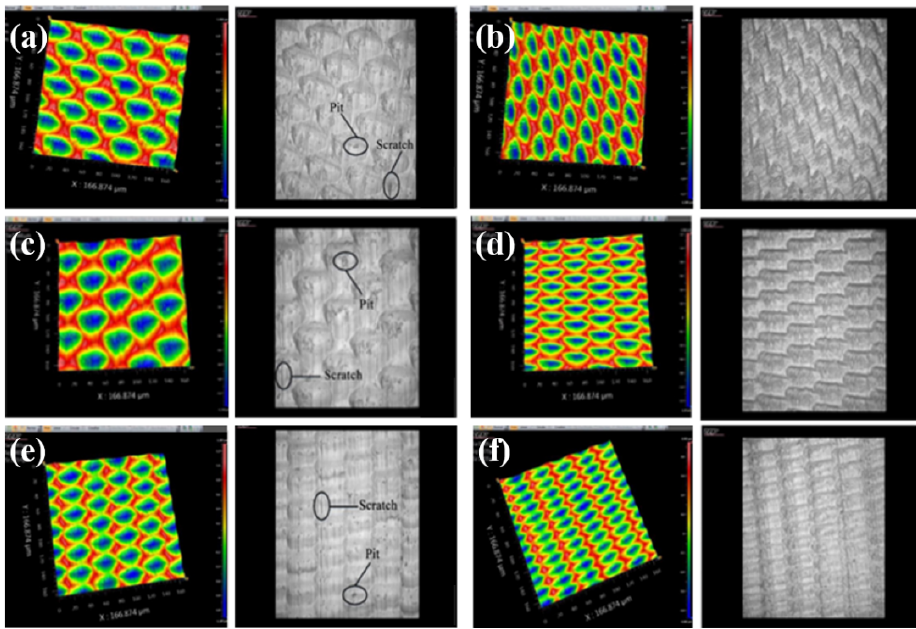
Figure 9. (a, c, e) Surface morphology after 3D EVC processing for the (a) copper rod, (c) aluminum rod and (e) titanium alloy. (b, d, f) Surface topography after 3D EVC processing controlled by robust adaptive fuzzy controller for the (b) copper rod, (d) aluminum rod and (f) titanium